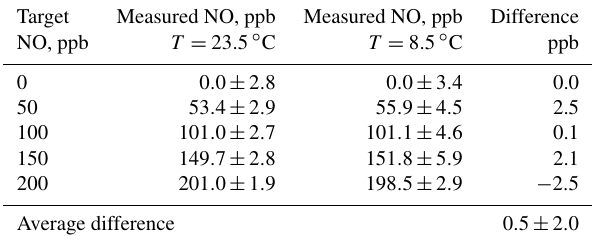
Table 3. Summary of the effect of temperature on the NO output concentration from a 2B Technologies Model 408 NO Calibration